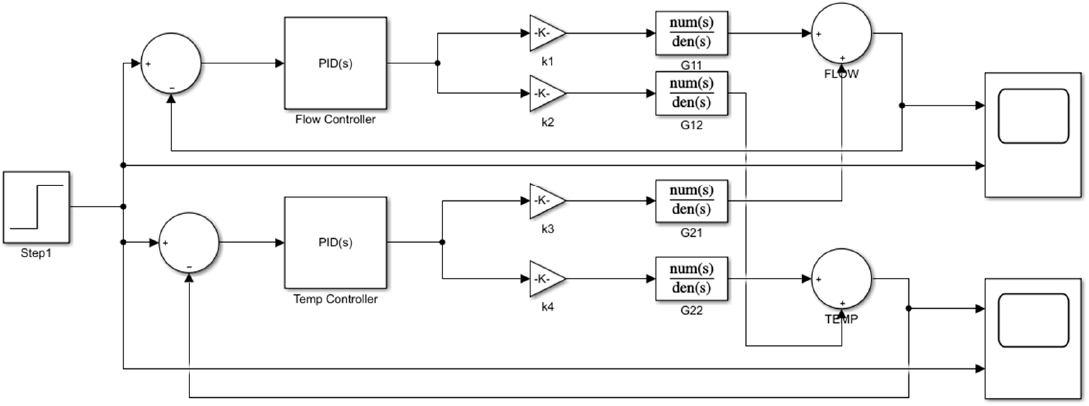
Figure 13. Simulink simulation of flow and temperature system (Z–N, PSO, and SSO).